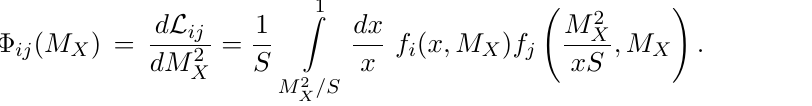
at the centre of mass energy X